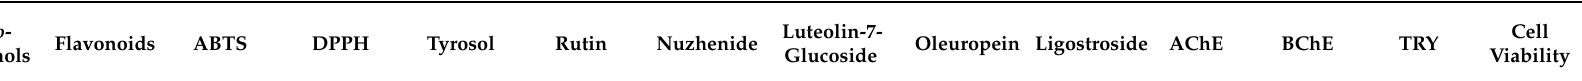
Table 5. Correlation analyses between the chemical composition, antioxidant capacity and inhibition of acetylcholinesterase (AChE), butyrylcholinesterase (BChE), and tyrosinase (TYR) of olive seeds